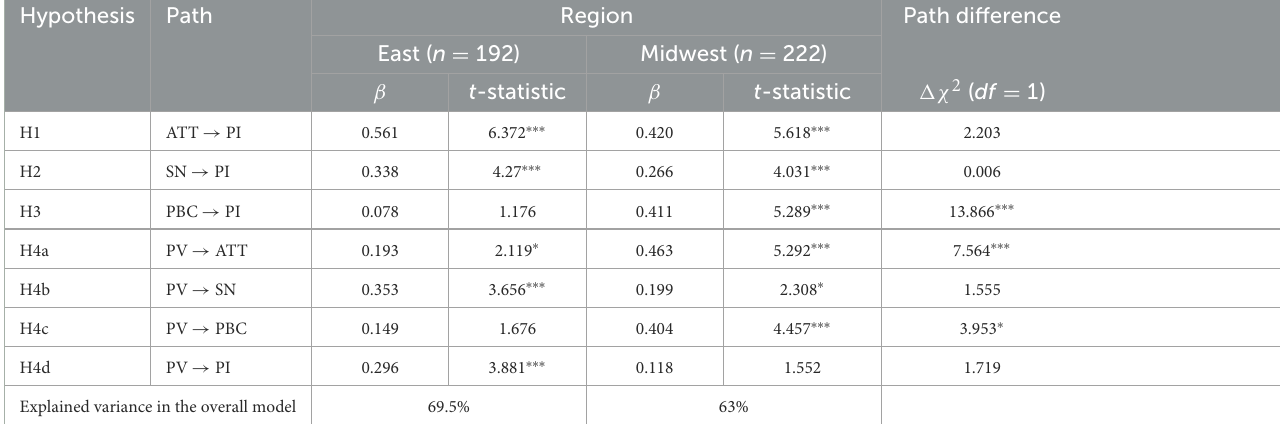
TABLE 8 Path coefficients comparison of MGA by region. Hypothesis